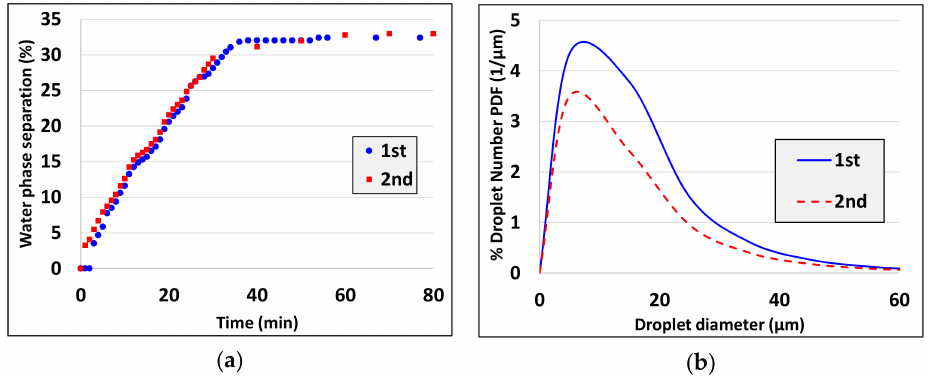
Figure 5. Repeatability test of emulsion production: ( a ) water phase separation and ( b ) droplet size distribution of emulsions (C SDS = 1 CMC, t n = 2 min, ϕ = 0.5 and f = 10Hz; Piston 1, 1 st : d av = 14.4 µ m,